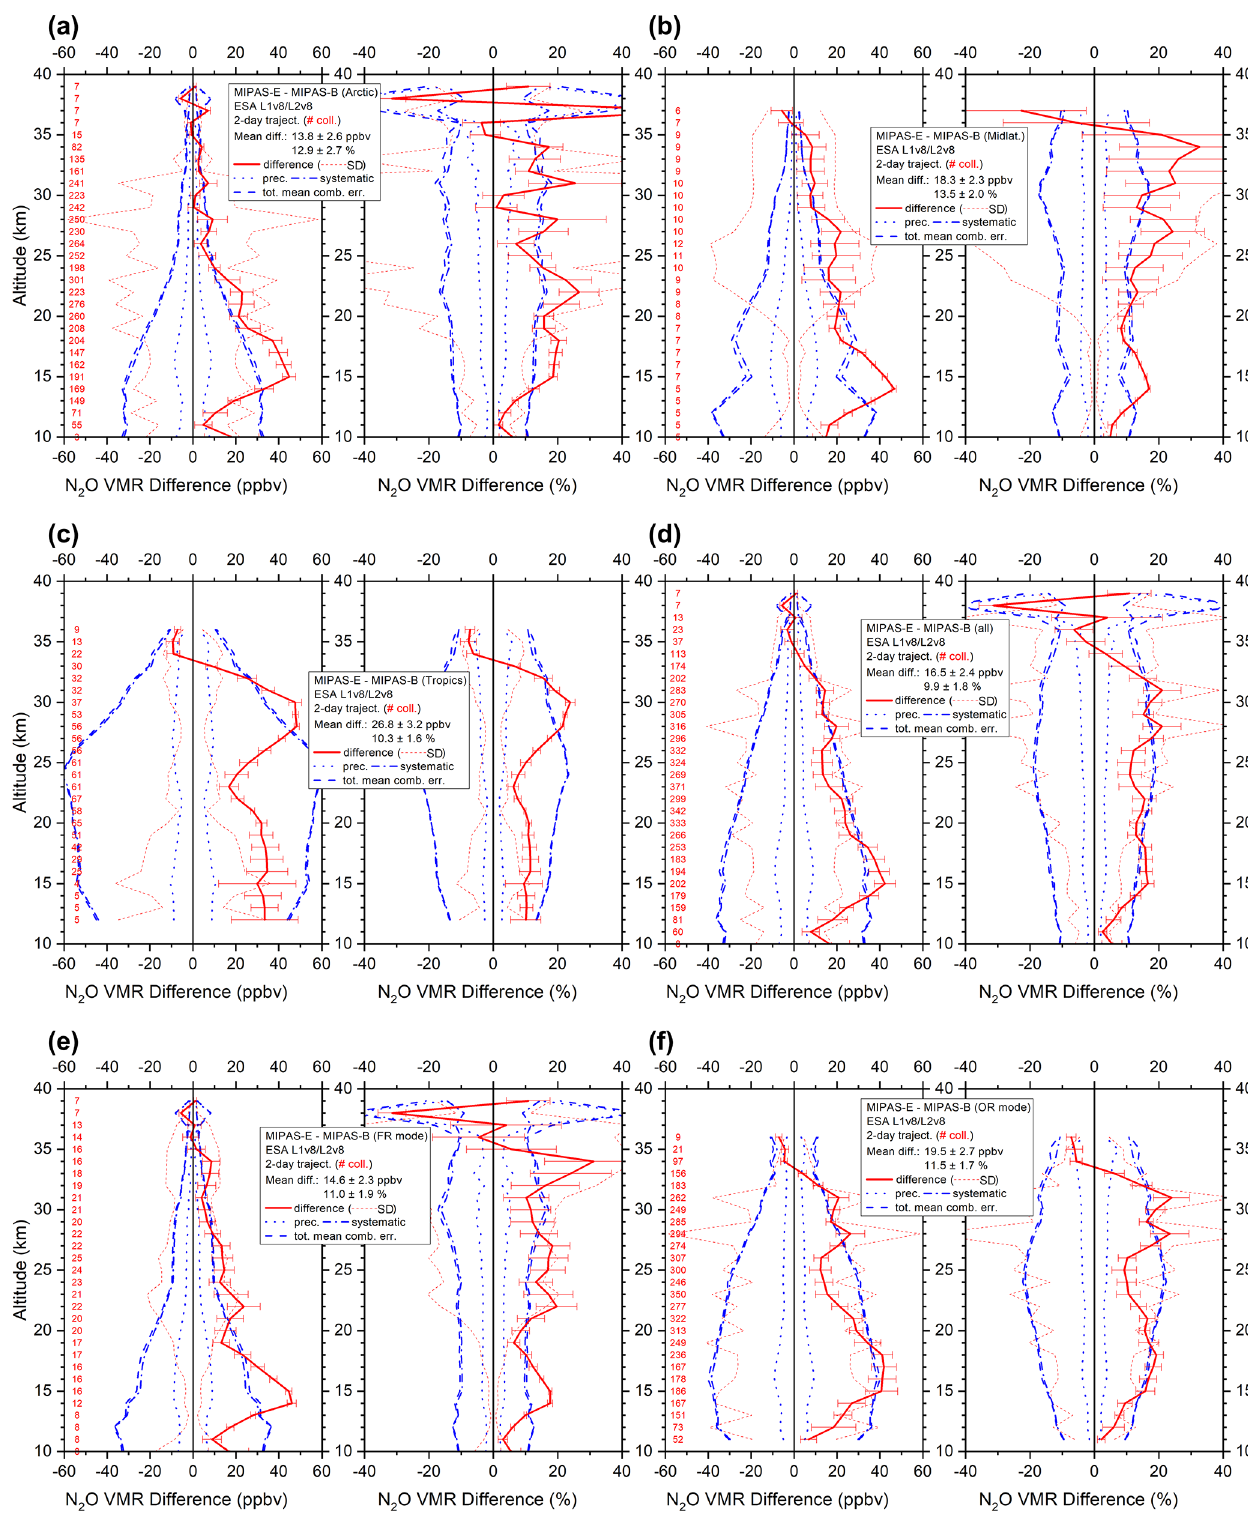
Figure 7. Same as Fig. 3 but for N 2